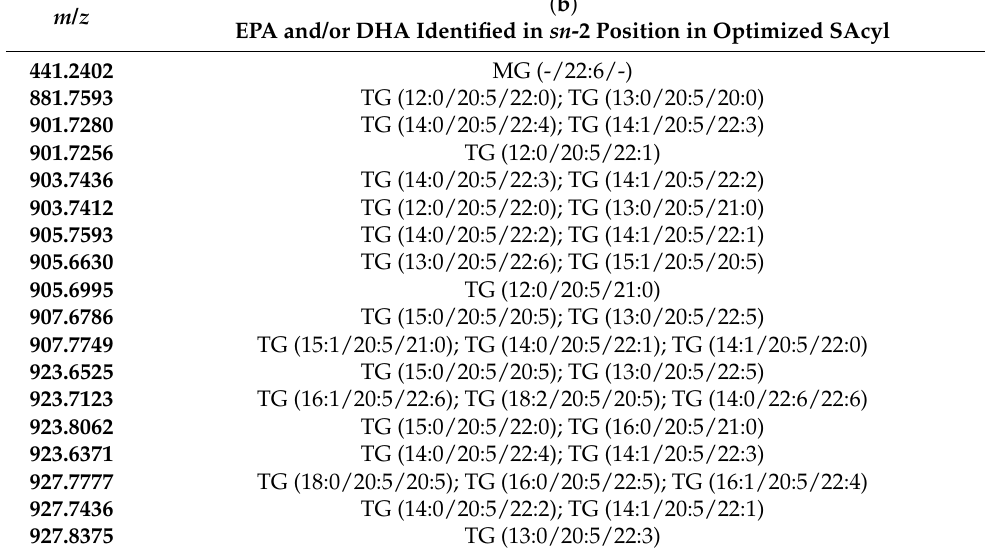
Figure 5. MALDI-TOF mMass report spectrum resulting from SAcyl obtained between 100 and 900 m / z ratio values. The m / z ratio signals corresponding to MG, DG, and TG presenting EPA/DHA at the sn -2 position are marked in red. Database: LIPID MAPS for glycerolipids. The optimized SAcyl and the CRSO were simultaneously evaluated by mass spec- trometry (MALDI-TOF) to compare the probable number of EPA/DHA fatty acids in the sn- 2 position of the glycerol backbone. Table 5 summarizes the number of acylglycerols identified with EPA/DHA in the sn -2 position by mass spectrometry (MALDI-TOF).